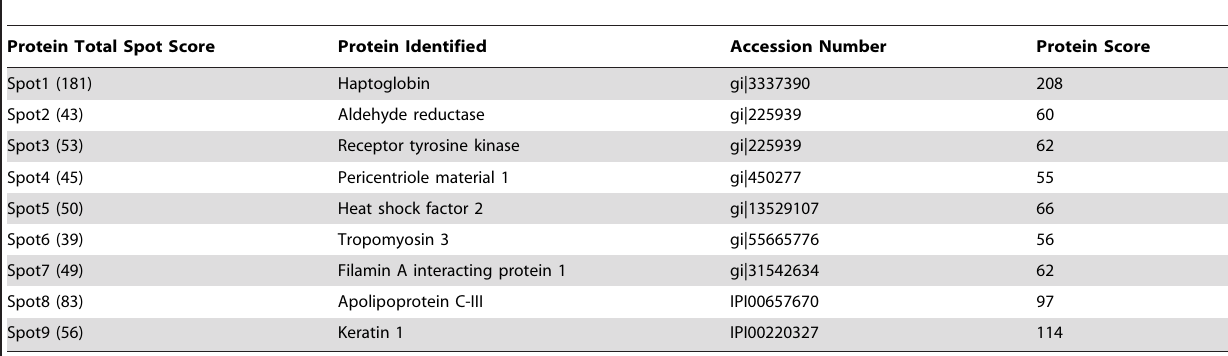
Table1. Protein spot identification by MALDI-TOF MS in conjunction with PMF with SWISS-PROT and NCBI non-redundant protein database